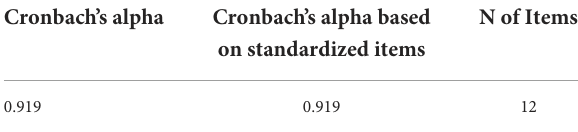
TABLE 4 Reliability